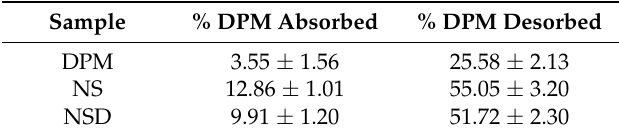
Table 3. Absorption and desorption of DPM in Caco-2 cells from DPM, NS and NSD samples. Data are expressed as the mean ± standard deviation.